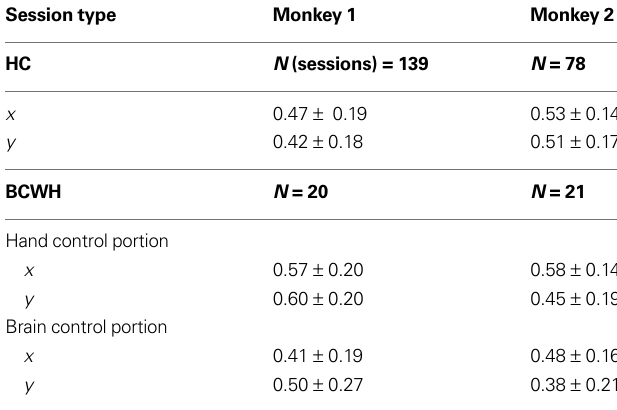
Table 1 | Average prediction accuracy. Correlation coeffi cient between the actual hand movements and movements as predicted from cortical activity across different behavioral conditions for two monkeys. Sessions with brain control with hand movements (BCWH) are shown split into the initial hand control portion, when the online fi lter was trained, and the subsequent brain control portion. The mean ± standard deviation is